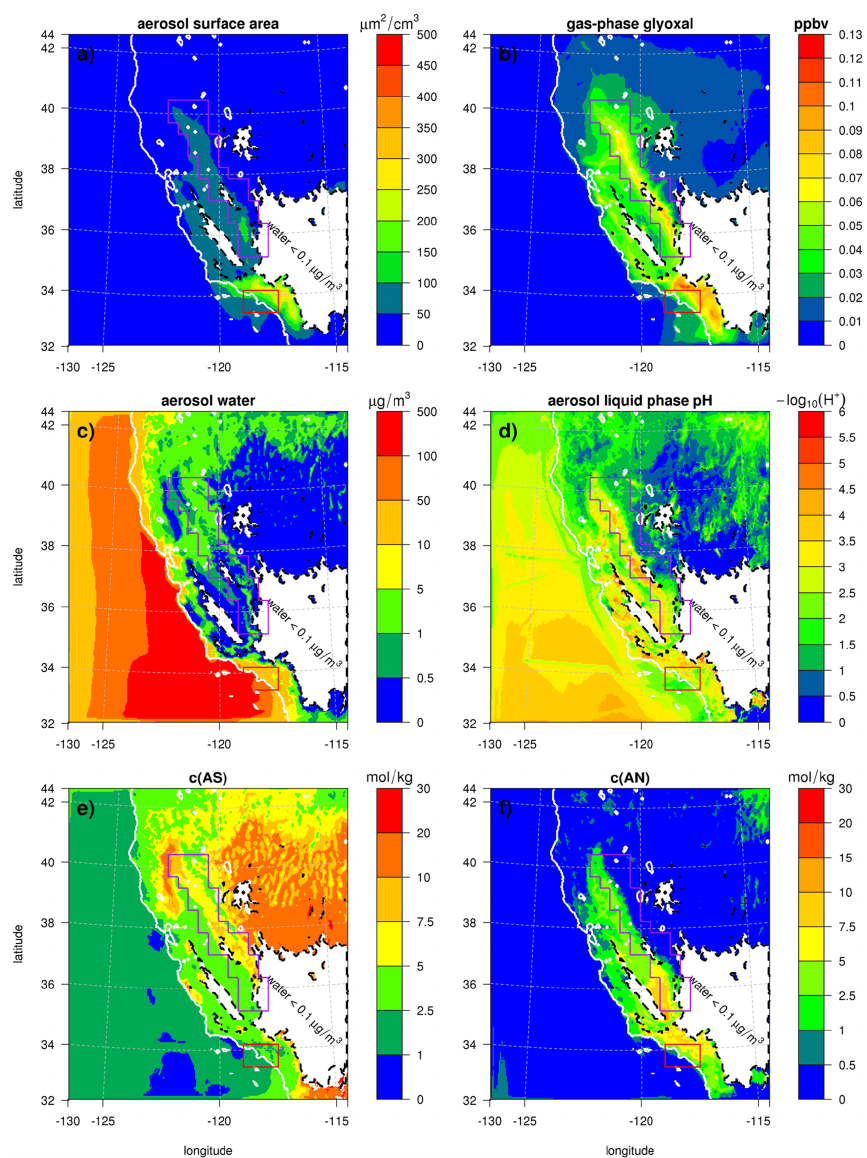
Figure 9. Maps of averaged aerosol related quantities in the lowest model layer (from top-left row-wise): (a) aerosol surface area, (b) gas- phase glyoxal, (c) aerosol water, (d) aerosol pH, (e) ammonium sulfate and (f) ammonium nitrate salt concentrations in aerosol water. White lines delineate land mass. Regions with predominantly dry particles (avg. water content < 0 . 1µgm − 3 ) were masked. Salt concentrations and pH show mean for time steps where an aqueous aerosol phase existed. Red and purple outline indicate LA and ESCV focus regions